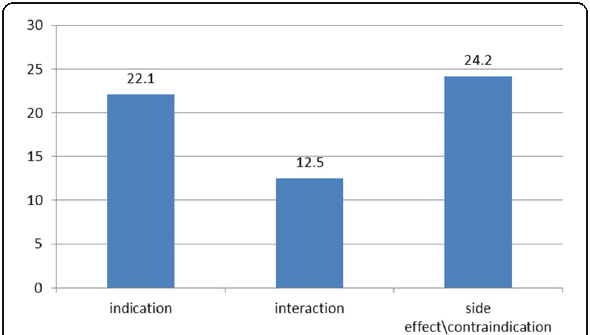
Fig. 4 Percentage of participants who correctly answered all